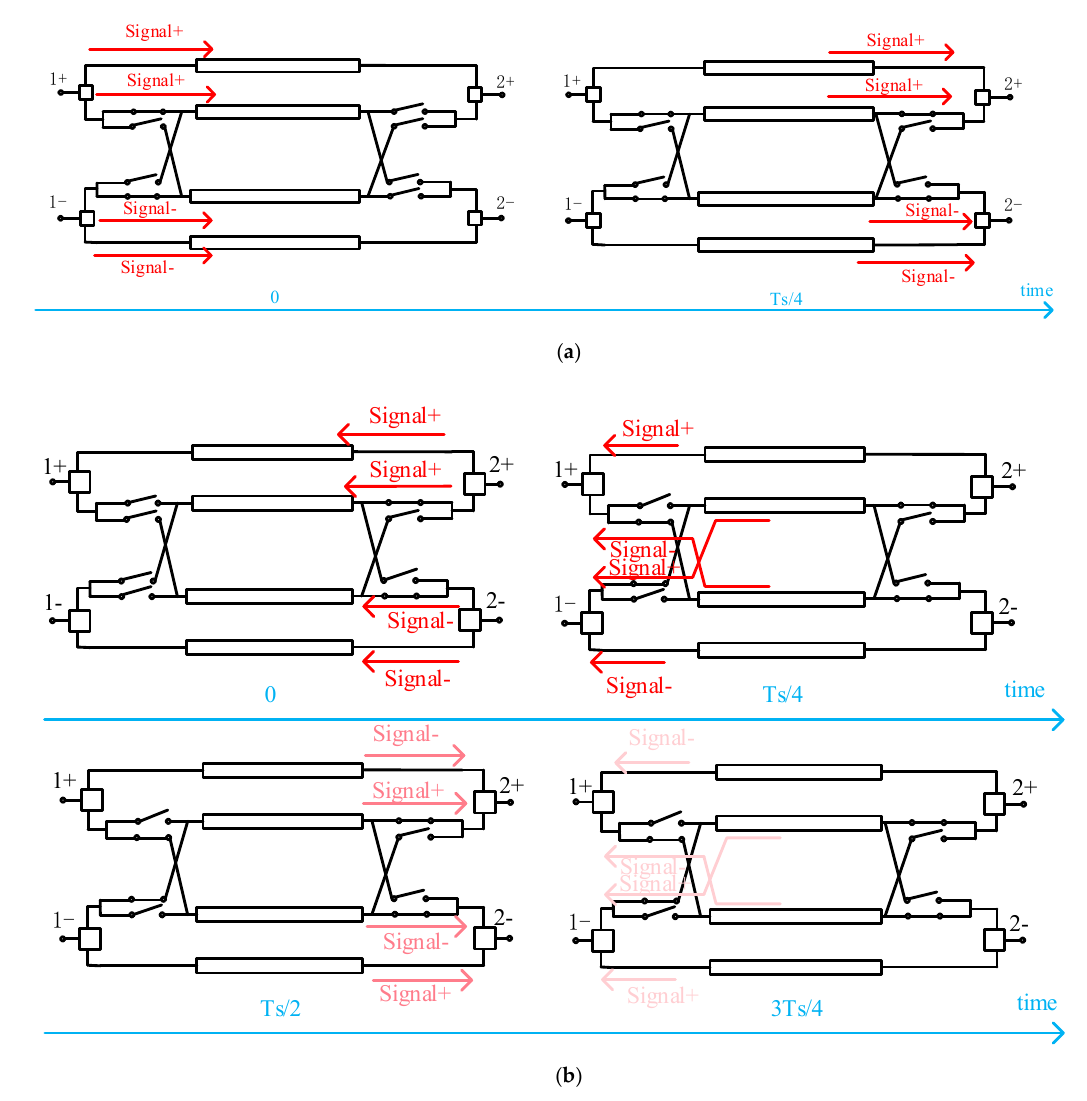
Figure 4. The transmission process in the DTI. ( a ) Input from port 1+(1 − ); and ( b ) input from port 2+(2 − ).